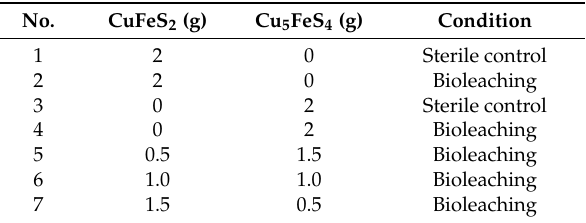
Table 1. Leaching experiment